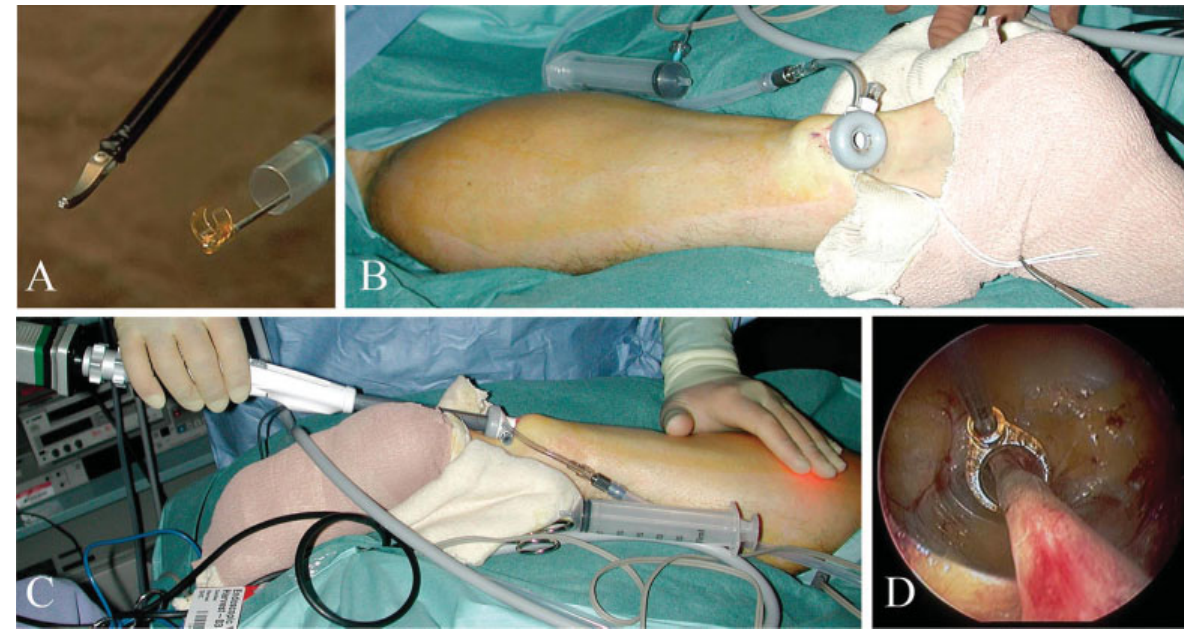
Fig. 7 Endoscopic extraction of sural nerve using bipolar dissector and C-ring with retraction system Guidant VasoView Uniport Plus.